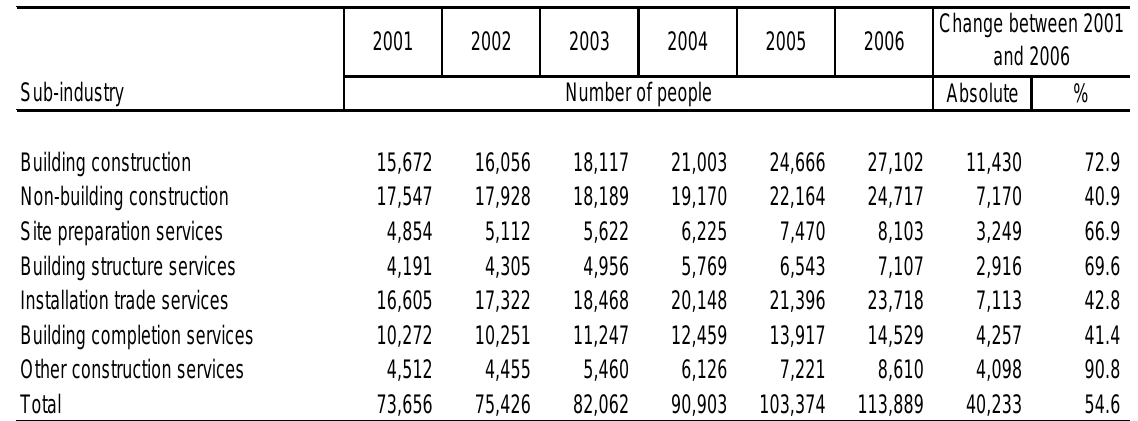
Wage and Salary Earners in Construction Industry March years